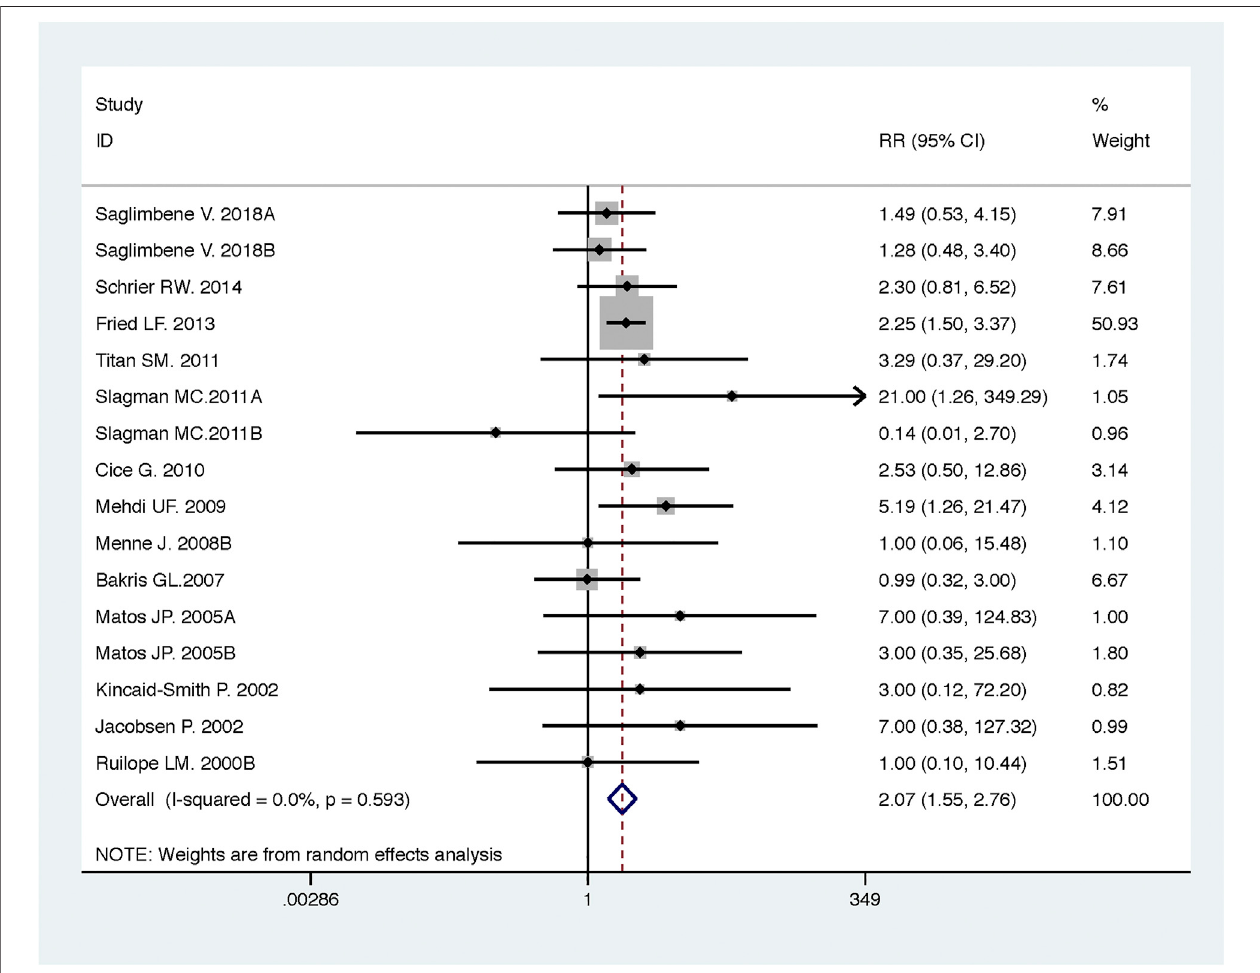
FIGURE 6 | Comparison of ACEI in combination with ARB vs. low-dose ACEI or ARB for development of hyperkalemia.